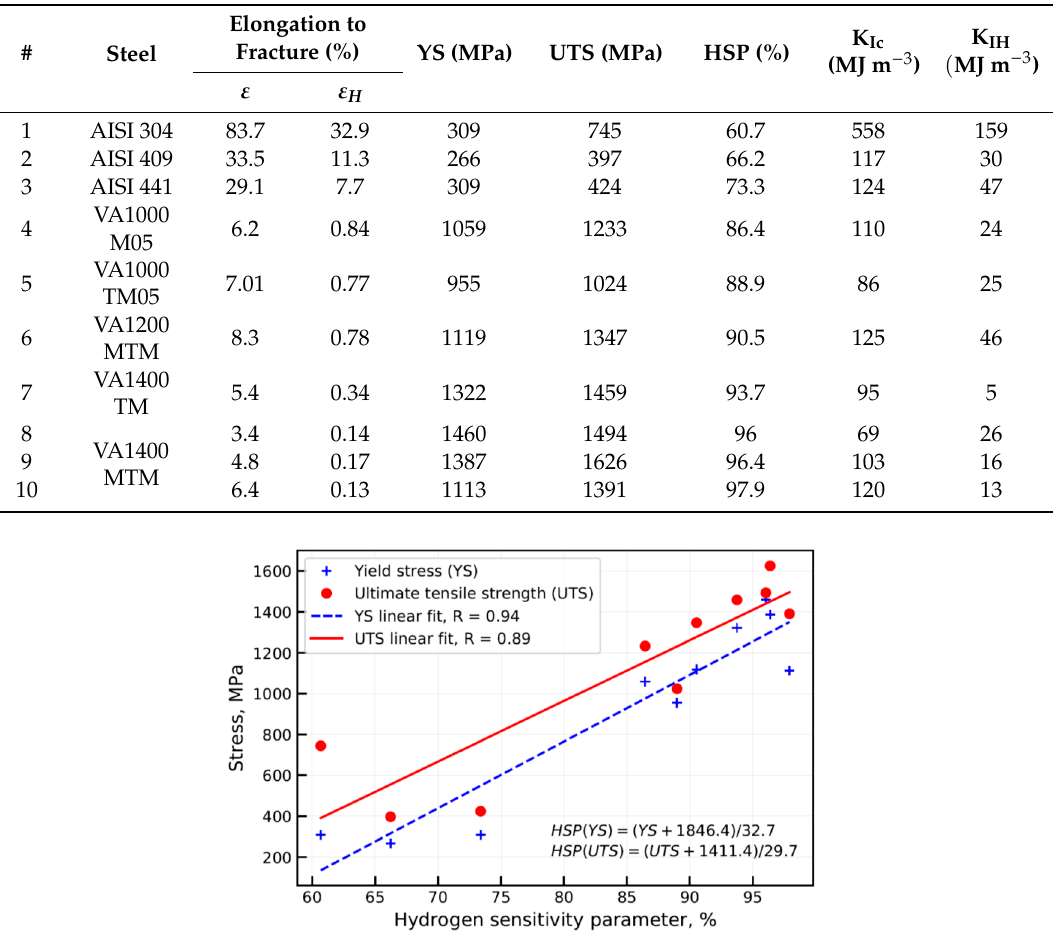
Figure 5. R-value calculated between the thermal desorption spectroscopy (TDS) curve-fitting parameters of the studied steels measured experimentally including yield stress (YS), ultimate tensile strength (UTS), and hydrogen sensitivity parameter (HSP) data. The regression ANN model (depicted in Figure 3) was developed and trained according to the methodology described in the Methods section. The ANN model was trained at the training dataset comprising six steel grades and 6000 data pairs. This provided training data covering a large domain of the targeted structural steels. During training, the developed model was validated at the validation dataset comprising four additional steel grades and 4000 data pairs to find the optimal ANN model parameters corresponding to the minimum of MAE calculated at the validation dataset. After the training was complete, the HSP targets were predicted at the test dataset comprising 1000 data pairs for each studied steel to evaluate the accuracy of the developed ANN model. The test dataset included TDS fitting parameters that were not exposed during ANN model training and validation, that is essential for ANN model accuracy assessment. Worthy of note is that the test dataset contained the artificial TDS fitting parameters produced by the data augmentation procedure using the same algorithm as for training and validation datasets, which may have resulted in some data leakage affecting the accuracy assessment. R-value calculated between the experimental and predicted HSP-